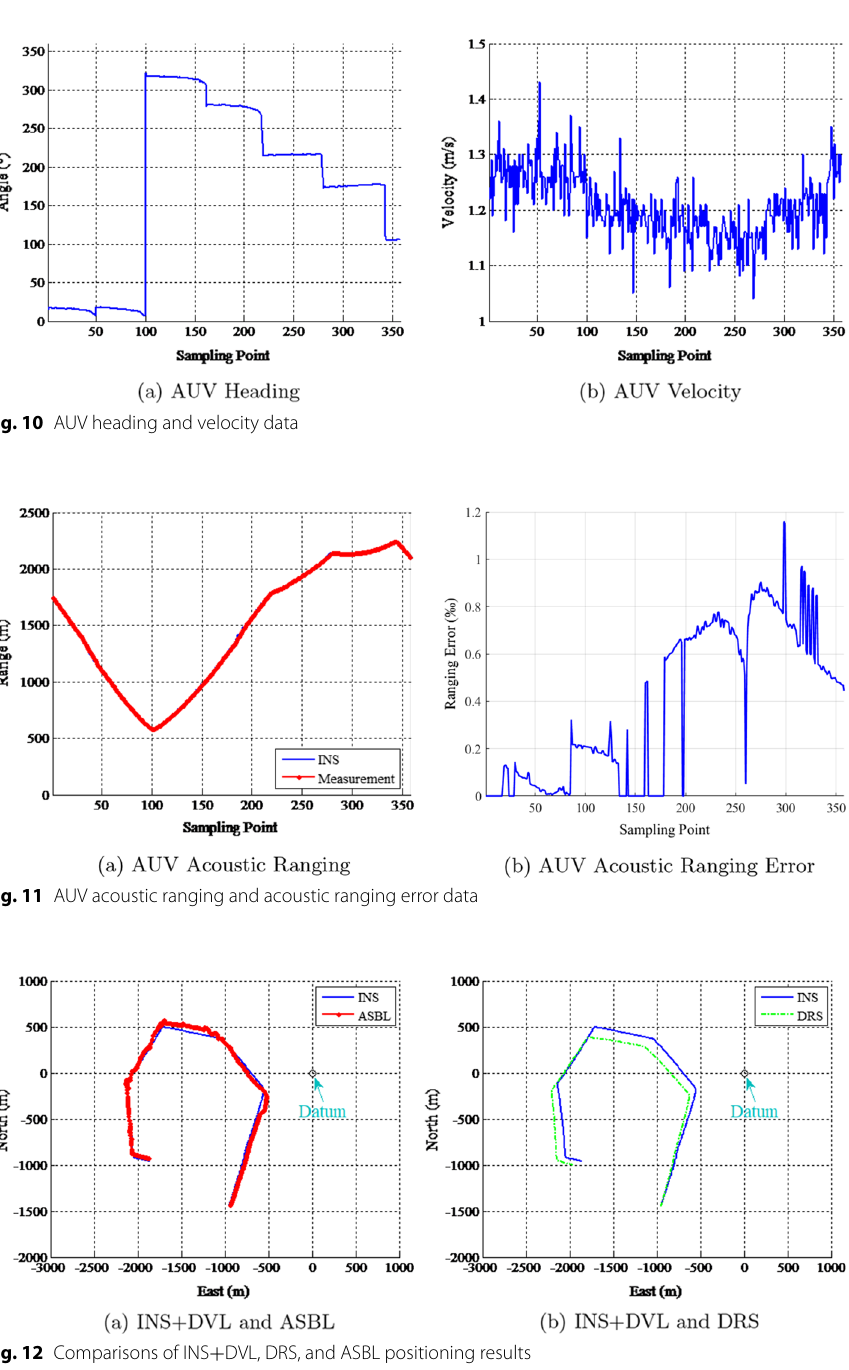
DVL, DRS, and ASBL positioning +